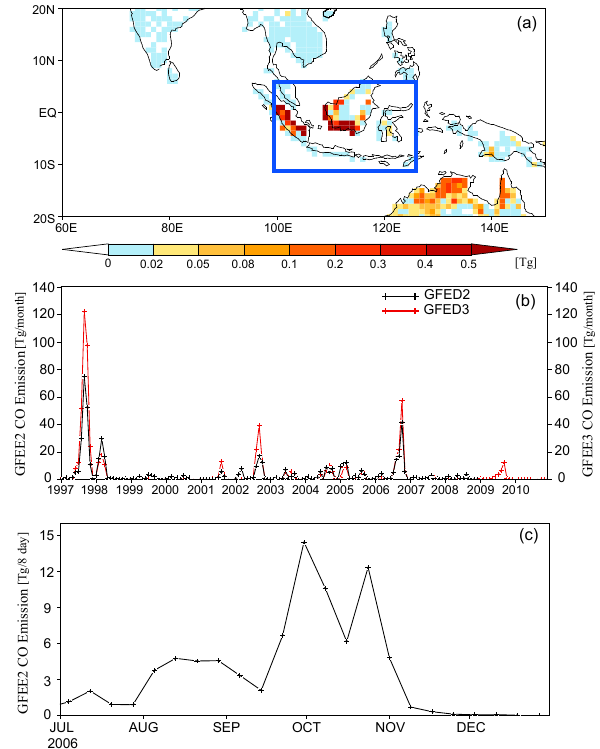
Fig. 1. Carbon monoxide emissions in 2006 over Indonesia and adjacent regions: (a) total emissions for August-November 2006 from GFED v2, (b) monthly emissions over Indonesia (5 ◦ N–10 ◦ S, 100 ◦ E-125 ◦ E) for 1997–2007 from GFED v2 and GFED v3, and (c) emissions with 8-day temporal resolution over Indonesia from July to December 2006 from GFED